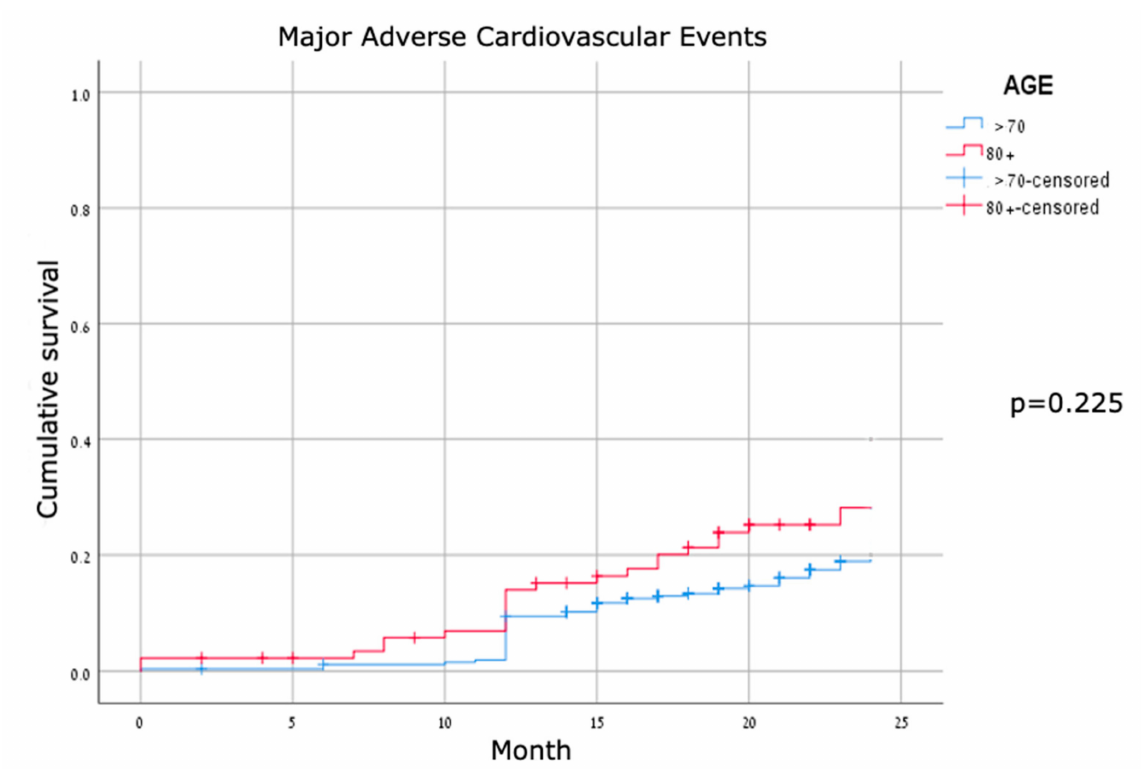
Figure 4. Kaplan–Meier curves for